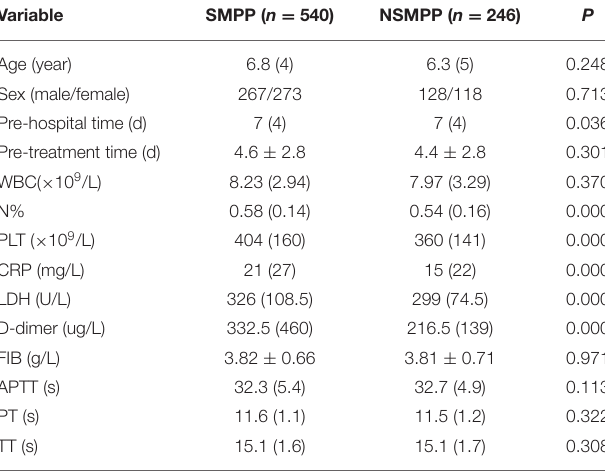
TABLE 1 | Clinical characteristic univariate analysis between SMPP and